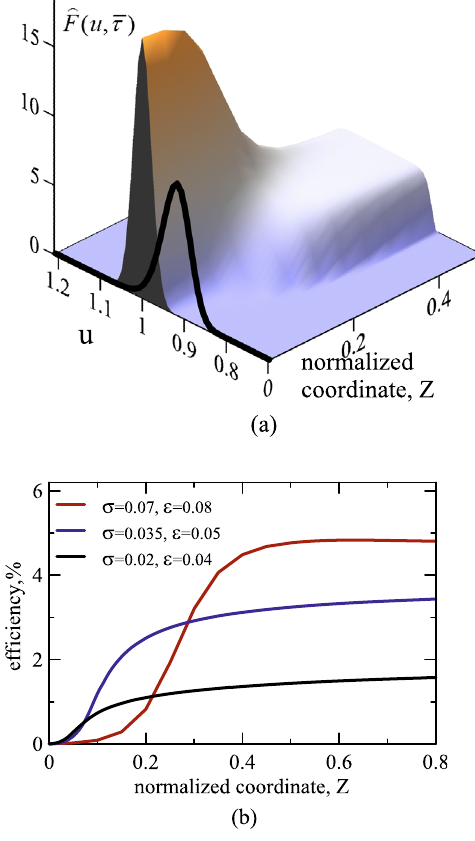
FIG. 3. (a) Spatial evolution of the electron distribution ⌢ ð u; Z Þ for the initial electron energy dispersion function F δ ¼ 0 . 02 , pump spectrum half-width σ ¼ 0 . 07 , and relative shift ε ¼ 0 . 08 , which is optimal for efficiency. Pump spectrum profile is shown by the black line. (b) Dependences of the electron efficiency η on the amplification length Z for the different pump spectrum half-width σ and the optimal relative shift ε